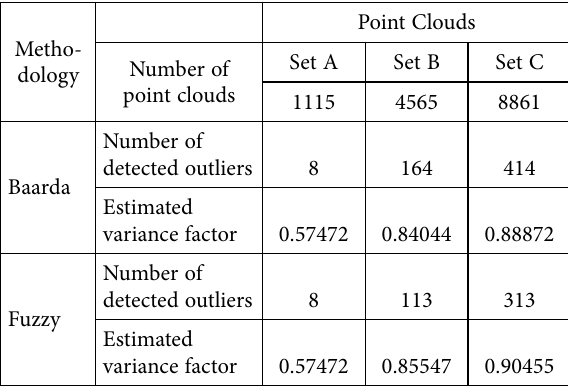
Table 2. Comparison of Baarda method and Fuzzy approach to detect outliers for 3D laser scanner point clouds Metho-